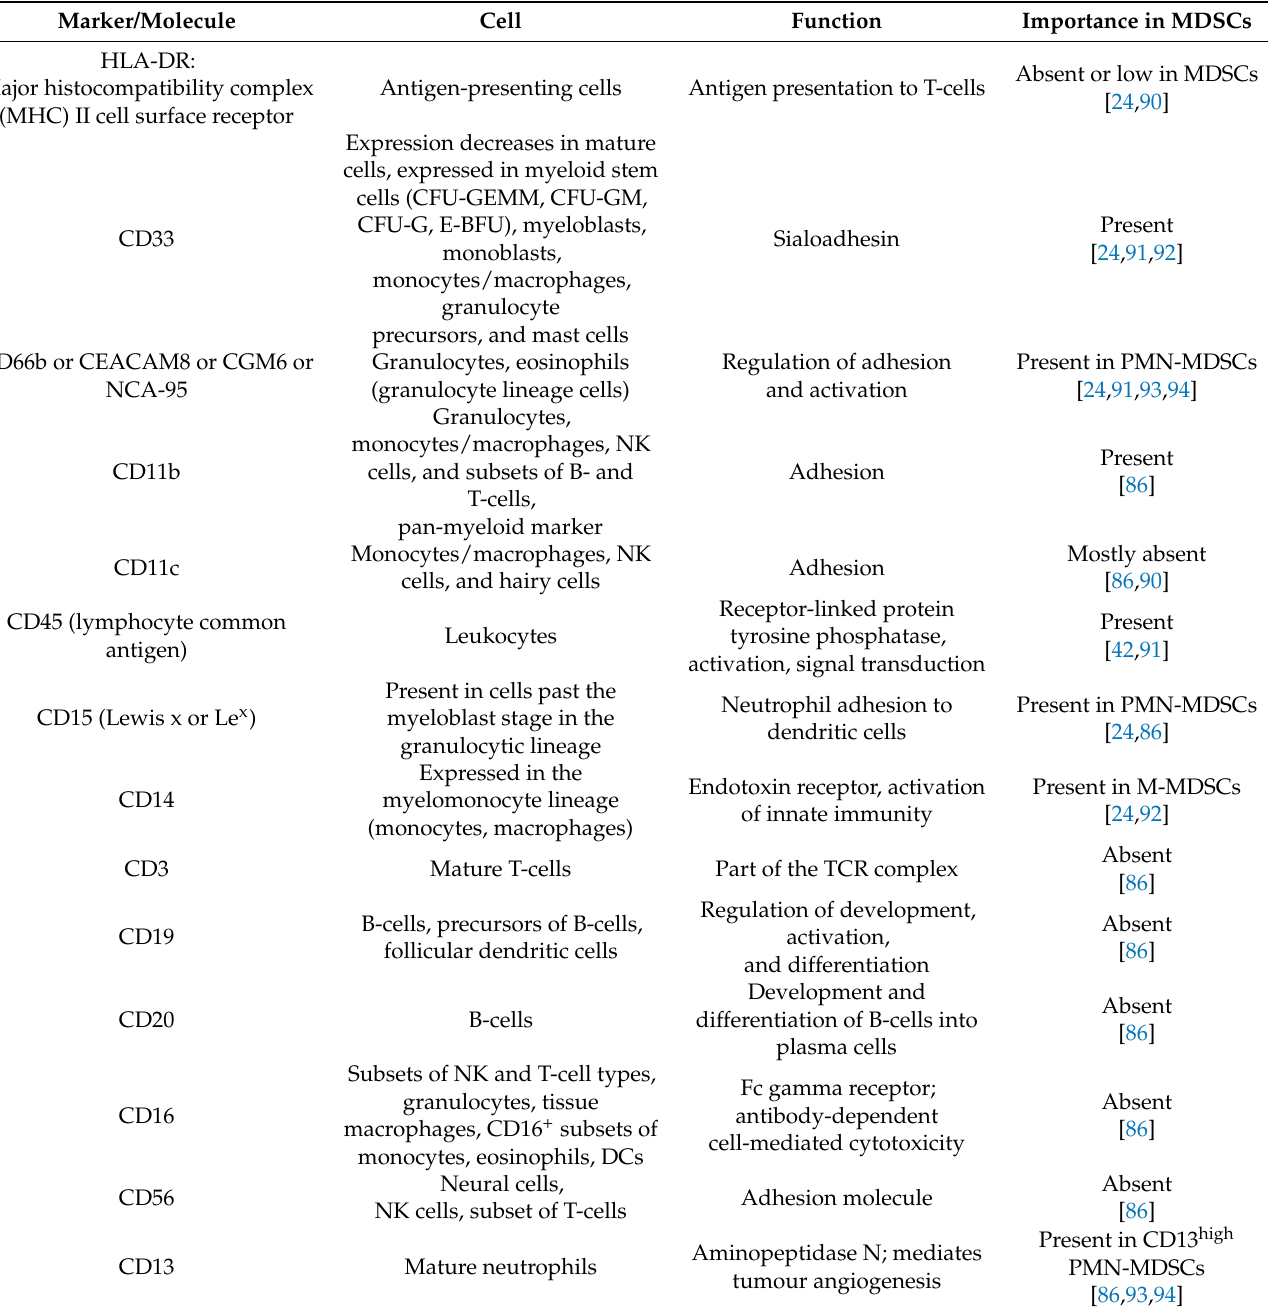
Table 3. Markers and molecules important for the study and identification of